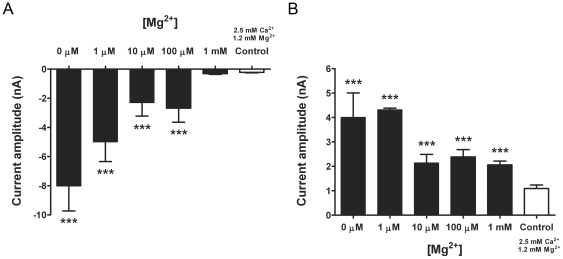
Increasing external [Mg2+] inhibits IDF activation.Mean ± S.E.M. Vagal neurons were held at −120 mV and stepped to −70 mV to record the inward current (A) or stepped to +60 mV to record the resulting outward current (B). Neurons were perfused with normal bath solution containing 2.5 mM Ca2+ and 1.2 mM Mg2+ (Control; white bar), or solution containing 5 mM EGTA and different [Mg2+] (0 µM, 1 µM, 10 µM, 100 µM and 1 mM; solid black bars). Statistical analysis was carried out between control conditions and increasing [Mg2+] using the unpaired Student's t-test (*** p<0.005).